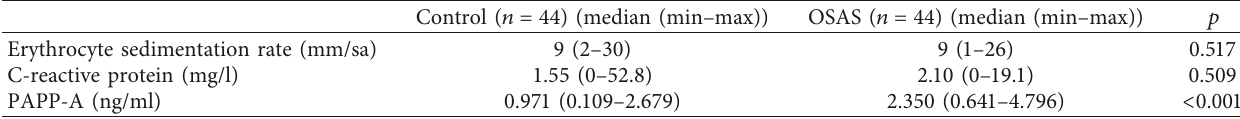
Table 4: Erythrocyte sedimentation rate, C reactive protein, and PAPP-A levels in the groups.